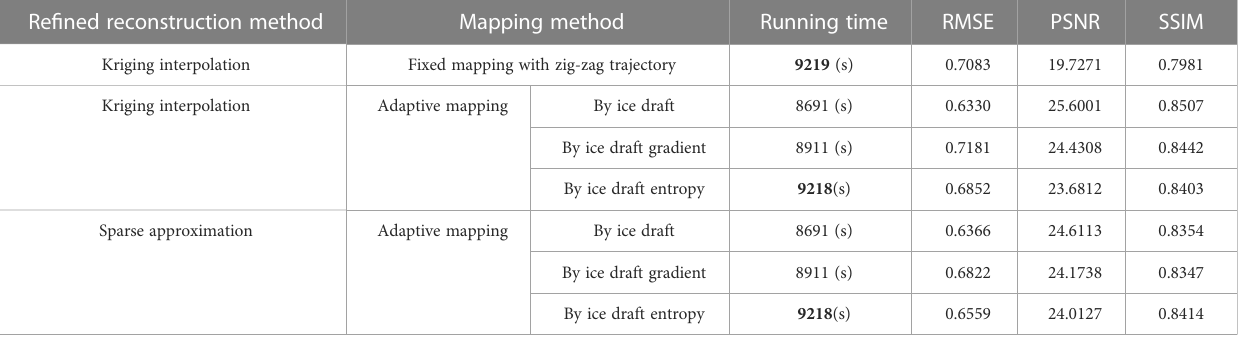
TABLE 1 Comparison of reconstruction results.